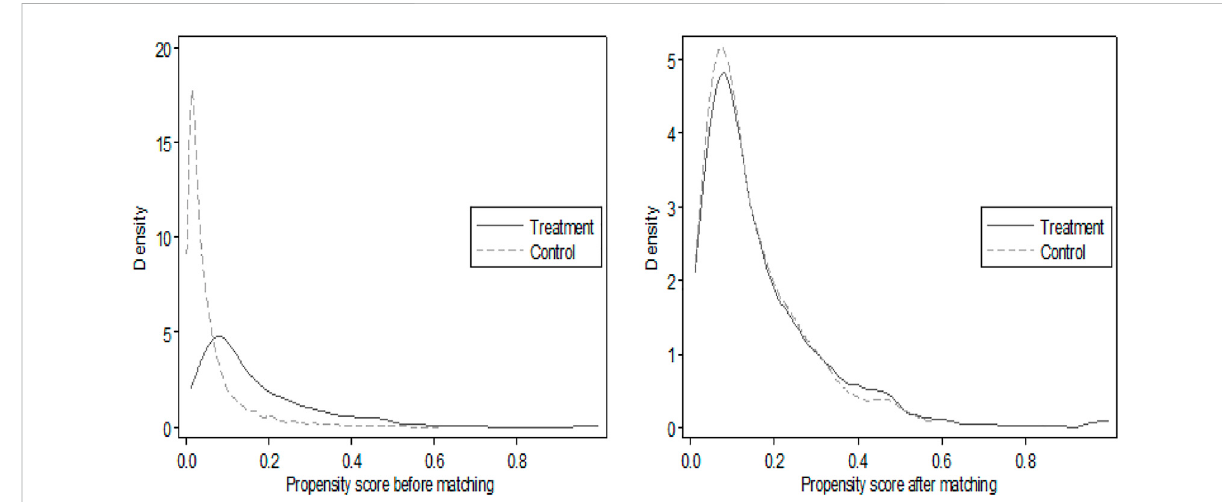
FIGURE 2 Comparison of kernel density before and after matching.